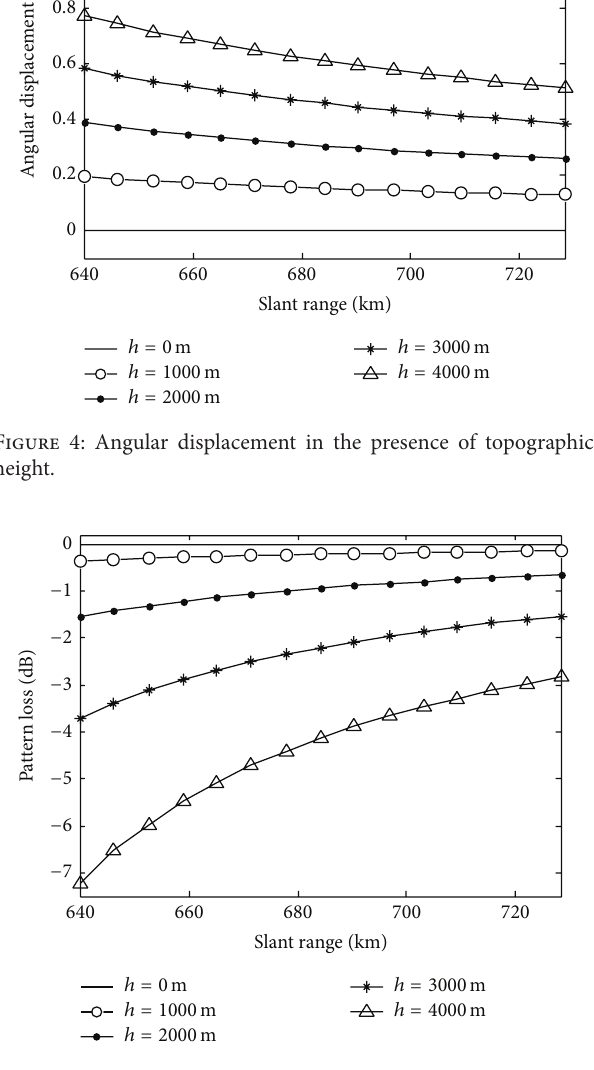
Figure 5: SCORE pattern loss in the presence of topographic height.